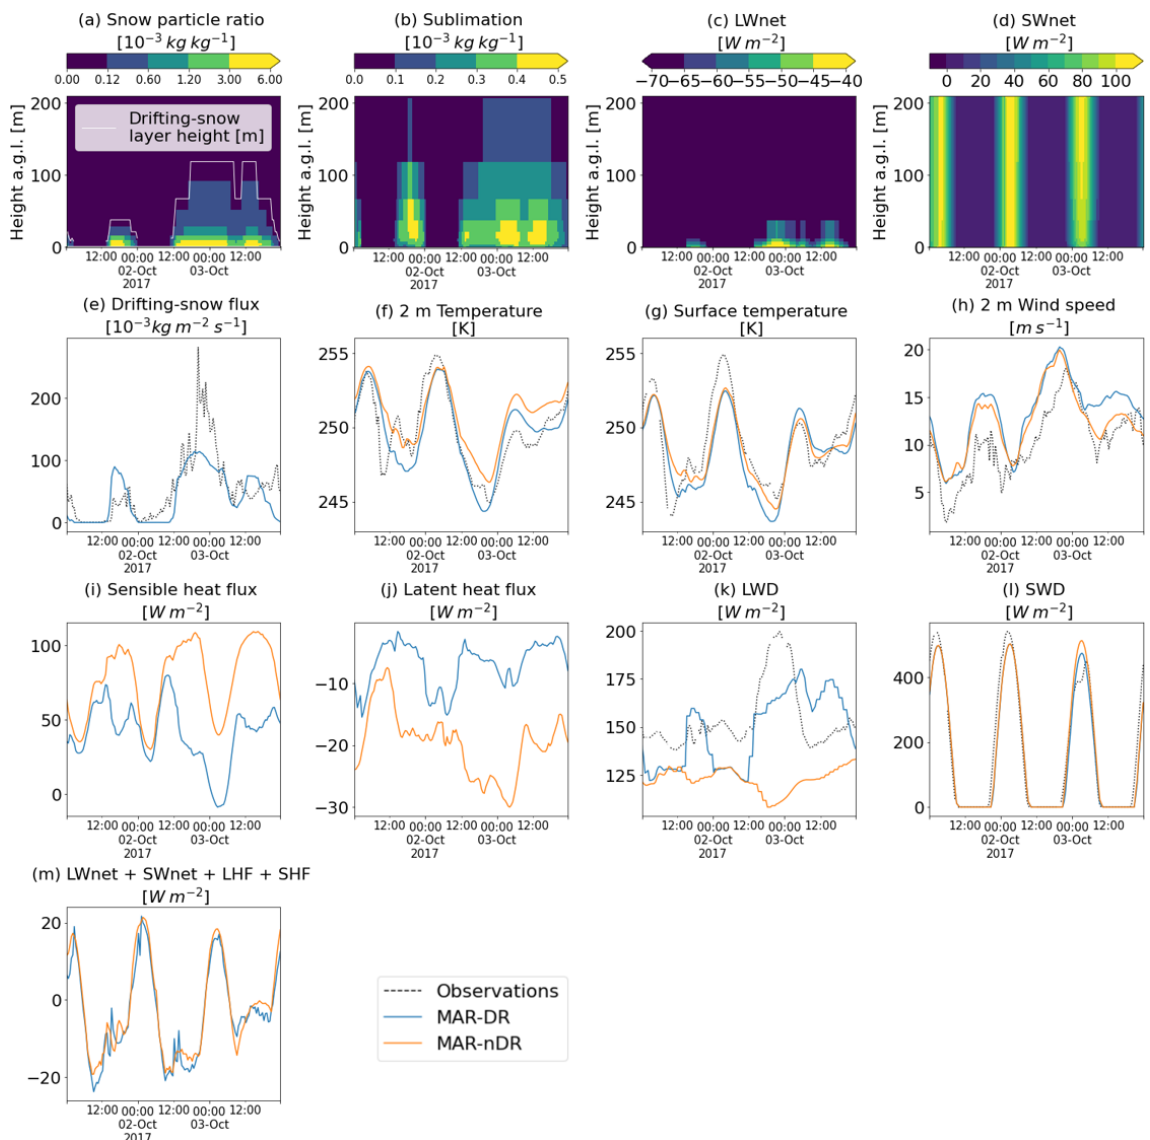
Figure 3. (a) Snow particle ratio, (b) sublimation (expressed in grams of sublimated snow per kilogram of moist air per 30min), (c) SWnet, and (d) LWnet vertical profiles as simulated by MAR-DR during a drifting-snow episode occurring between 1 and 3 October 2017. (e) – (m) 2m and surface variables as observed and simulated by MAR-DR and MAR-nDR between 1 and 3 October